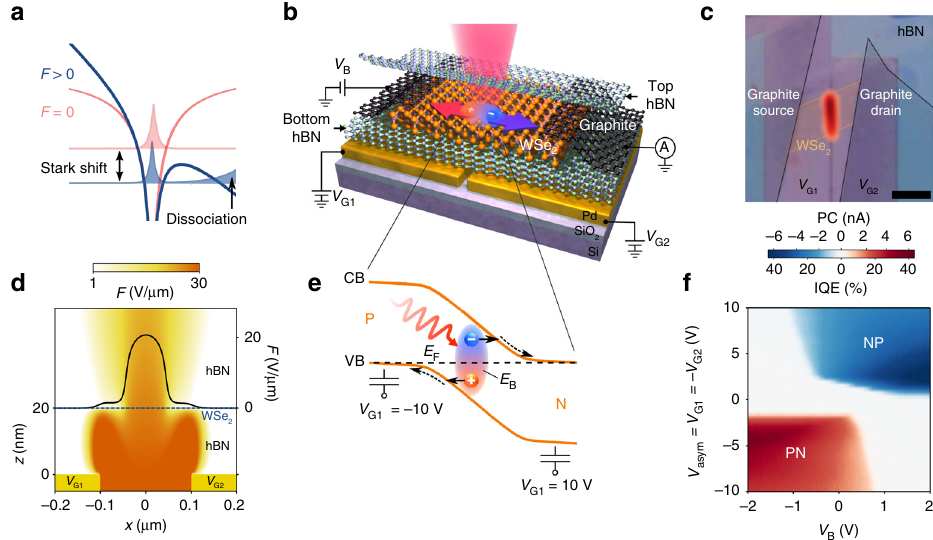
Fig. 1 Photocurrent generation by exciton dissociation in a monolayer WSe 2 p – n junction. a Illustration of a Wannier – Mott exciton in the absence (red) and presence (blue) of a static electric fi eld. The exciton wave functions are represented by the shaded curves while the exciton potentials are shown by the thick solid lines. b Schematic of a monolayer WSe 2 device controlled by two local metal gates with voltages V G1 and V G2 . Two graphite fl akes (colored in black) are placed on both sides of the WSe 2 layer (orange) and encapsulated between two hBN fl akes (pale blue and green). c Optical image of a p – n junction device overlaid with a spatial PC map. The graphite and WSe 2 fl akes are outlined and shaded for clarity. PC is measured at V asym = V G1 = − V G2 = − 10 V and V = 0 V, with a laser power P = 1 μ W and a photon energy h υ = 1.65 eV. The scale bar is 4 μ m. d Side view of the electric fi eld distribution F B across a device made of hBN (20 nm thick), monolayer WSe 2 (dotted blue line), and hBN (30 nm thick) atop metallic split gates separated by 200 nm ð F Þ . The in-plane electric fi eld (yellow rectangles). The fi eld is calculated for V asym = − 10 V and V B = 0. The color bar above indicates the magnitude of log 10 F ( x ) inside the WSe p – n junction between x = − 0.1 and 0.1 μ m (cf., Fig. 1d) calculated 2 is shown by the solid black line (right axis). e Band diagram of the for V asym = − 10 V and V B = 0 V. The solid orange lines represent the conduction (CB) and valence band (VB) and the black dotted line corresponds to the Fermi level ( E F ). Following resonant optical excitation (red sinusoidal arrow), excitons are generated and dissociated via tunnel ionization (solid black arrows). The resulting free carriers drift out of the junction (dotted black arrows) and generate a photocurrent. f PC measured at the junction as a function of V asym and V B , with a laser power P = 0.5 μ W and a photon energy h υ = 1.65 eV. The color bar between c and f displays the magnitude of the PC as well h ν A = 5% is the absorption coef fi as the internal quantum ef fi ciency, IQE ¼ PC e AP , where 0